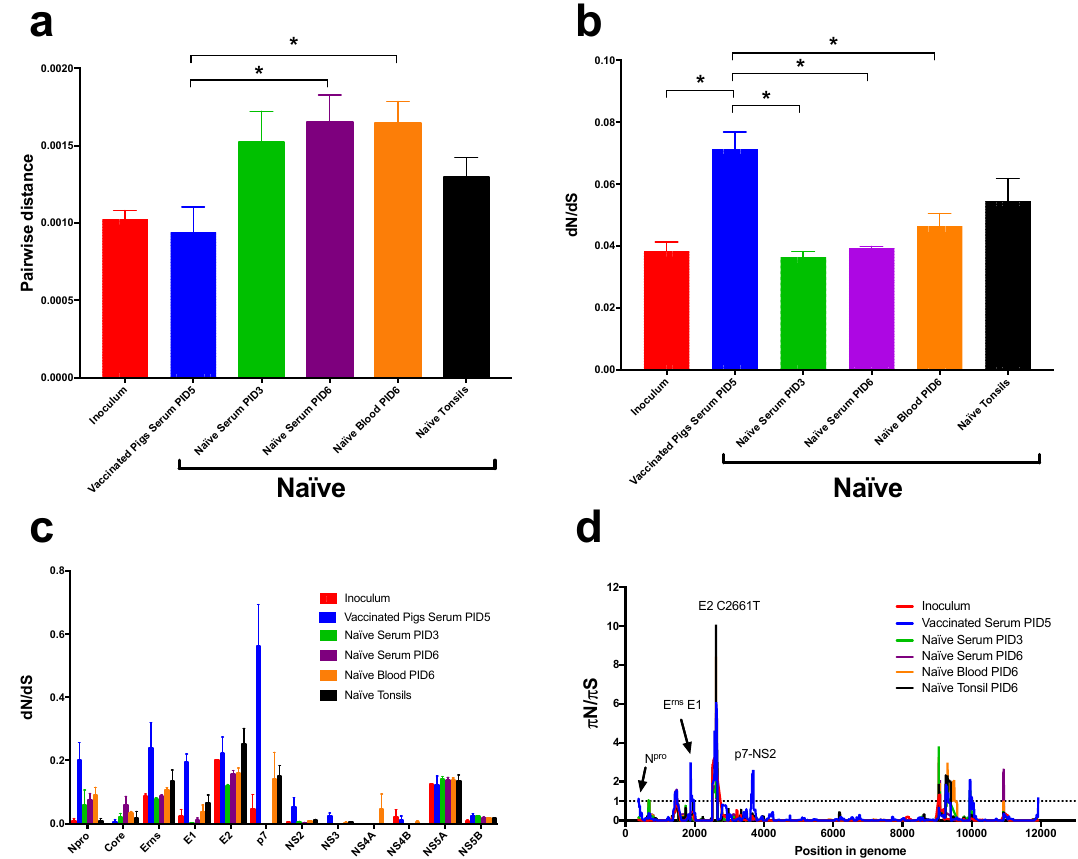
Figure 7. Population diversity derived by selection analysis of deep sequencing data. Panel ( a ) shows the pair-wise genetic distance plotted for each individual sample type across the complete ORF. Means ± SEM are shown for biological replicates ( n = 3 and n = 4) for the naïve and vaccinated groups, respectively, and technical replicates for the inoculum ( n = 2). The T-test was applied to determine significance differences between the vaccinated group compared to blood, tonsils, and serum (PID3 and PID6) of the samples from naïve pigs ( p = 0.0242*, p = 0.1649, p = 0.070*, p = 0.0304*), respectively, and to the challenge inoculum ( p = 0.7598) with * indicating significant values. Panel ( b ) depicts the dN / dS ratio plotted for each individual sample type for the total ORF. The T-test was applied, as above, to determine significant differences between the vaccinated group compared to blood, tonsils, and serum (PID3 and PID6) of the naïve samples ( p = 0.0193*, p = 0.1165, p = 0.0033*, p = 0.0045*), respectively, and to the inoculum ( p = 0.0172*). Panel ( c ) shows the dN / dS ratios plotted for each individual protein-coding sequence from the inoculum, vaccinated, and naïve groups. Panel ( d ) shows the π N / π S ratios plotted as lines representing a 150 nt sliding window with the x-axis representing the position in the genome.